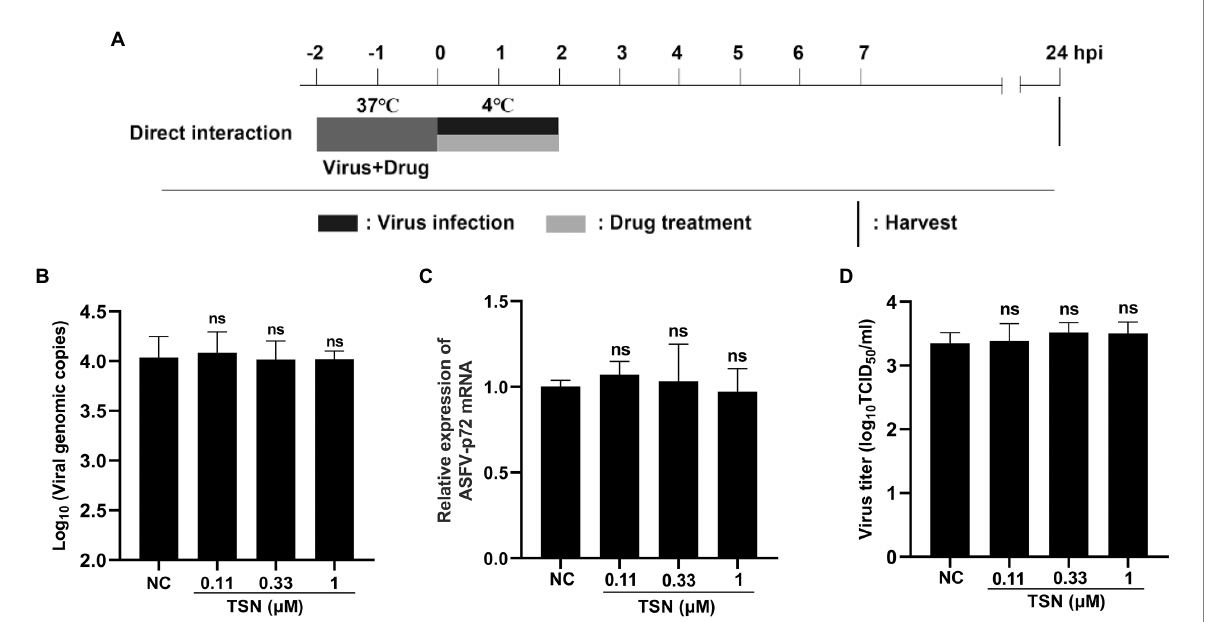
FIGURE 7 TSN has no direct inactivation on ASFV. (A) The mixture of ASFV (2 * 10 6 TCID 50 /mL) and TSN (0.11, 0.33, and 1 μ M) was incubated at 37 ° C for 2 h. Then the PAMs seeded in 48-well plates were challenged with the mixture and incubated at 37 ° C for 2 h. The supernatant was discarded and replaced with fresh maintenance medium. The samples were harvested at 24 hpi for qPCR, RT-qPCR and endpoint dilution method analysis. (B) The DNA level of the ASFV p72 gene was analyzed using qPCR. (C) The mRNA level of the ASFV p72 gene was analyzed using RT-qPCR. (D) Viral titer was investigated by endpoint dilution method as described in the Methods. ns denotes no significant difference. NC denotes the negative